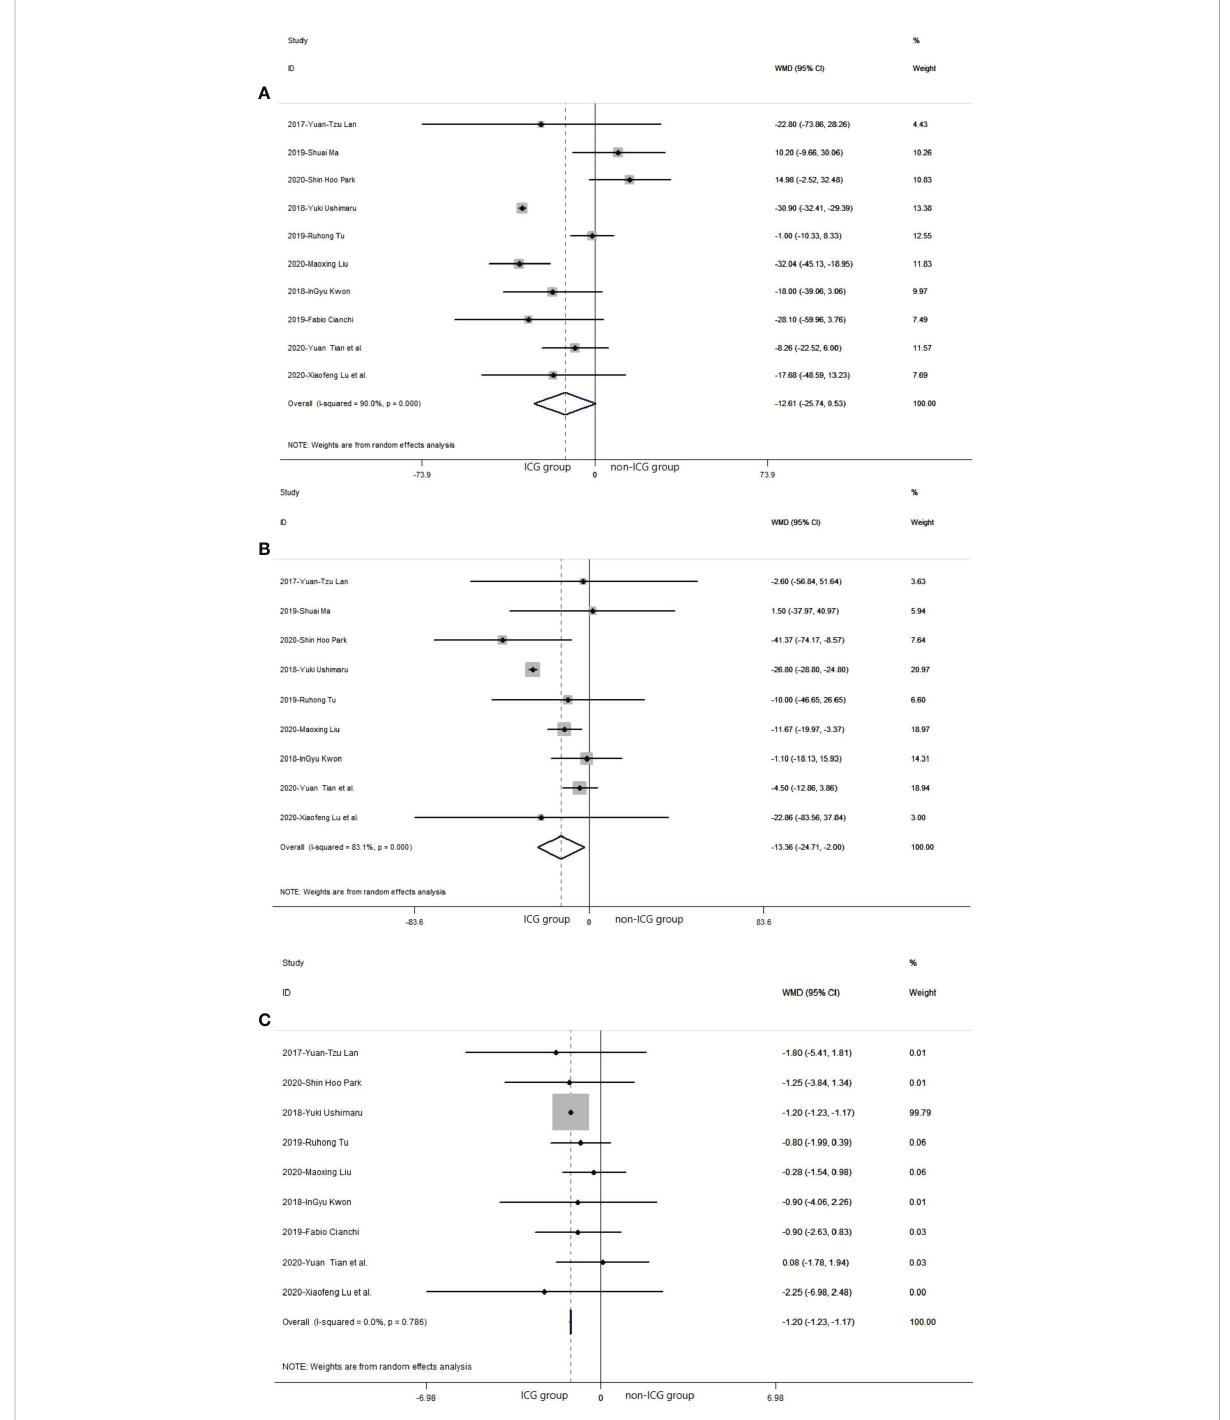
FIGURE 4 Pooled weighted mean difference of safety in laparoscopic gastrectomy with indocyanine green vs . conventional laparoscopic gastrectomy. (A) The pooled weighted mean difference of safety of included studies related to time of operation. (B) The pooled weighted mean difference of safety of included studies related to intraoperative blood loss. (C) The pooled weighted mean difference of safety of included studies related to time of postoperative